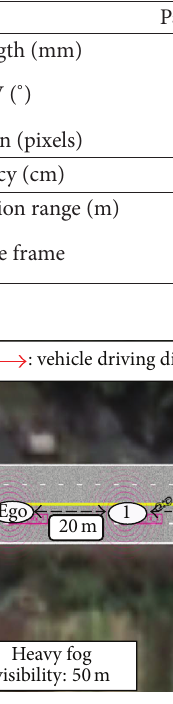
Figure 9: Initial road